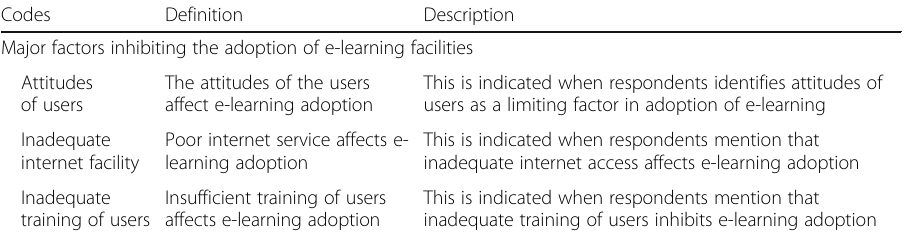
Table 4 Key factors inhibiting the adoption of e-learning facilities